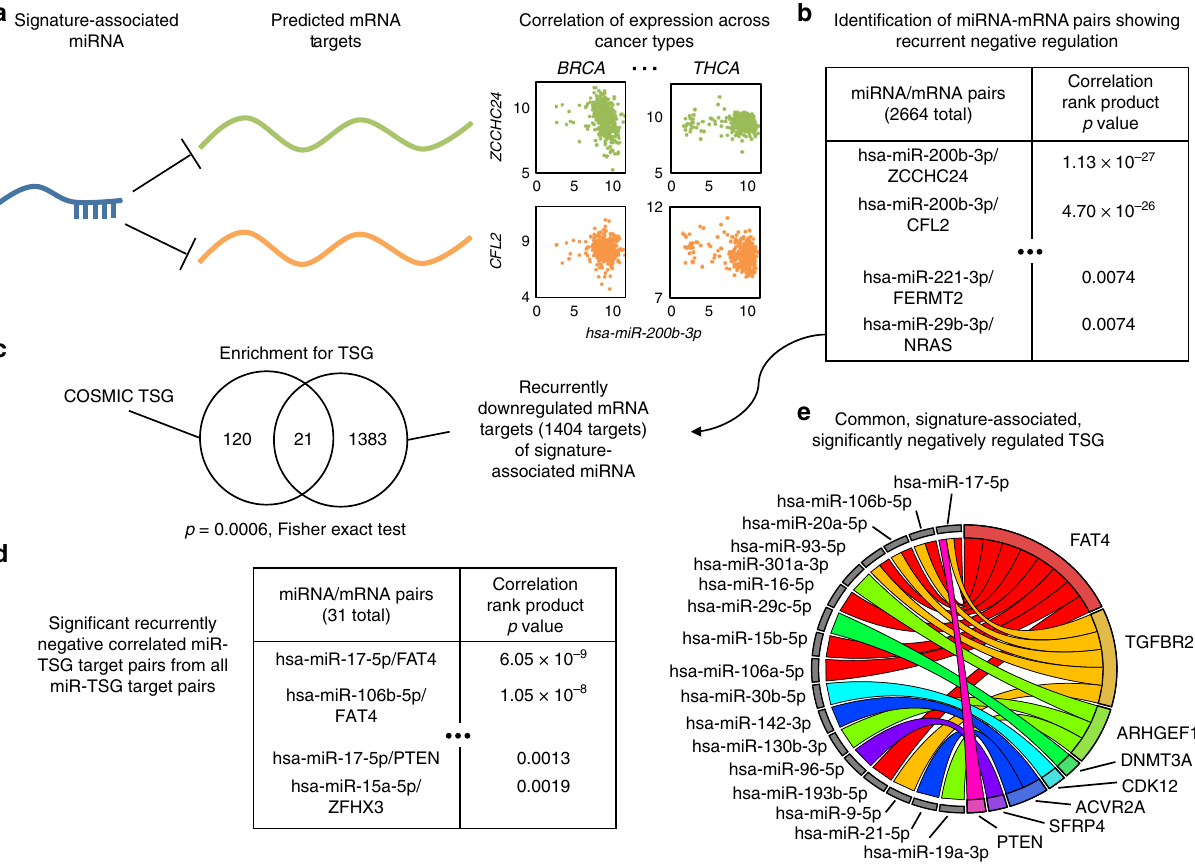
Fig. 2 Approach used for interpreting miRNA-target interactions. a First, miRNA-target pairs for each positively associated hallmark-associated miRNA were identi fi ed, and the correlation between these was determined. b Next, the correlations across cancer types were aggregated, and those identi fi ed as consistently negative-ranking were identi fi ed with the rank product statistic. c Among this list of miRNA-mRNA target pairs, there was highly signi fi cant enrichment for tumour suppressor genes, as identi fi ed by the Fisher exact test. d The same procedure as described in a and b was repeated for all miRNA and all predicted target TSG pairs, with each TSG considered individually. e From the lists identi fi ed in b and d , we identi fi ed those miRNA-TSG pairs in common, and plot their interactions on a circos plot, showing the repressive actions of each miRNA on its predicted target